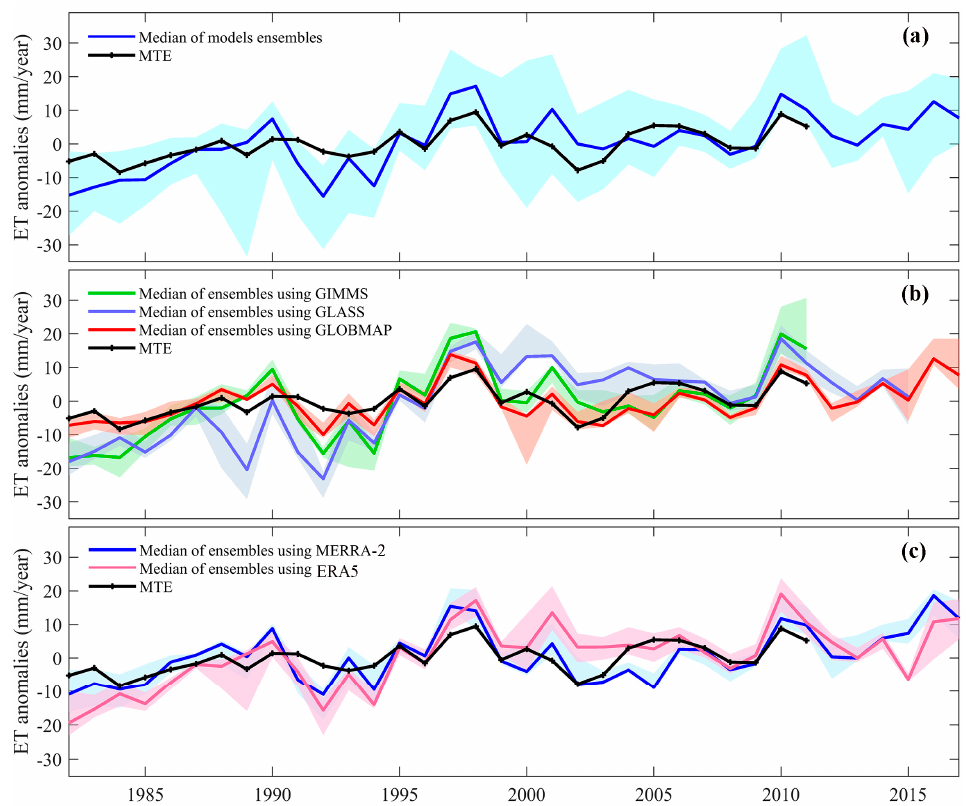
Figure 7. Global land ET anomalies. ( a ) Ensembles of global ET anomalies from 1982 to 2017 under all models and the forcing datasets. ( b ) The estimates of ET anomalies from three LAI datasets with di ff erent combinations of models and meteorological datasets. The green line (GIMMS), blue line (GLASS), and red line (GLOBMAP) represent the median of ET ensembles using the GIMMS, GLASS, and GLOBMAP LAI datasets, respectively. ( c ) The estimates of ET anomalies from two meteorological datasets with di ff erent combinations of models and LAI datasets. The blue line (MERRA-2) and pink line (ERA5) is the median of ET ensembles using the MERRA-2 and ERA5, respectively. The shading area indicates the inter-quartile of ET ensembles using di ff erent LAI and meteorological